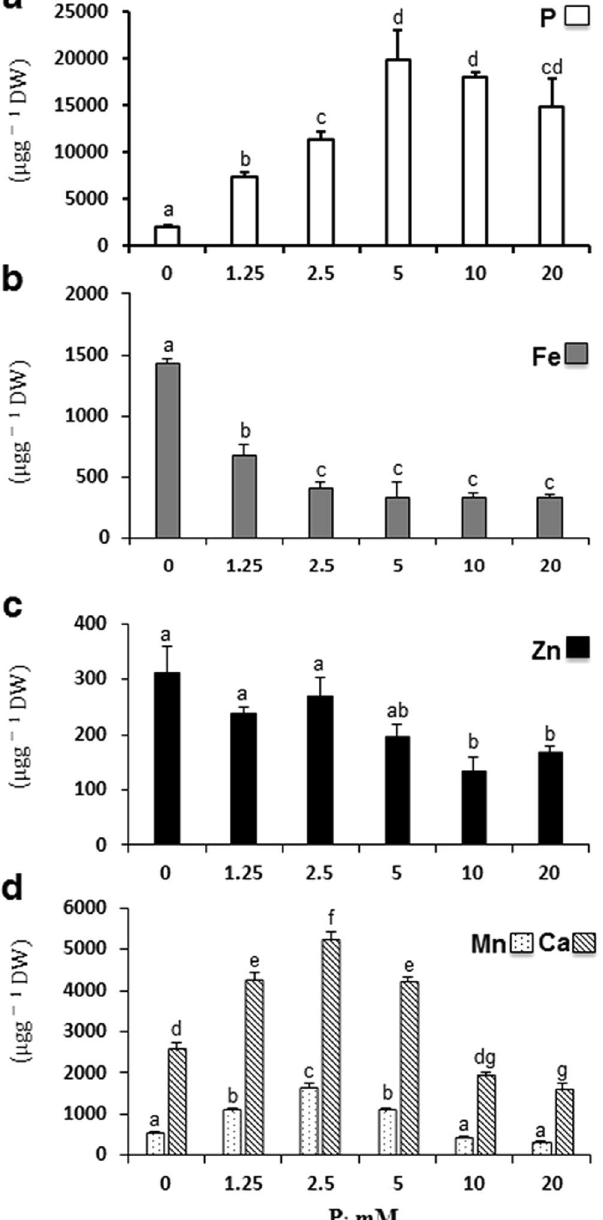
Figure 5. Metal nutrients analysis of Arabidopsis seedlings grown on varying concentrations of P i hydroponically as described in the legend to Fig. 1. Data are presented as phosphorus content ( a ), iron content ( b ), zinc content ( c ), manganese and calcium content ( d ). Values are means ± SE; n = 3 replicates of 25 mg of dry weight of seedlings tissue. Mean Bars with different alpha letter differ significantly (P ≤ 0.05) according to analysis of variance (1X-ANOVA) with Tukey’s Multiple Comparison